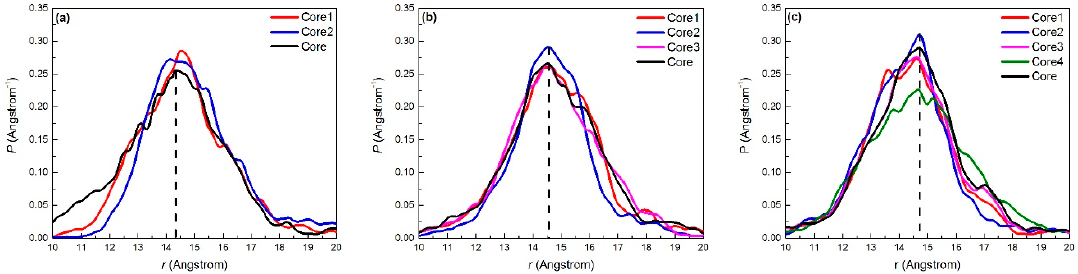
Figure 4. Density profiles for diffident centers in ( a ) Nap; ( b ) Phe; ( c ) Pyr at 398K on the MCM-41 model.